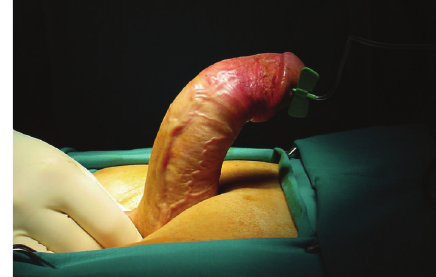
Figure 3: After having adjusted the tension of the second row of plication sutures, complete penile straightness with a fully inflated penile prosthesis is